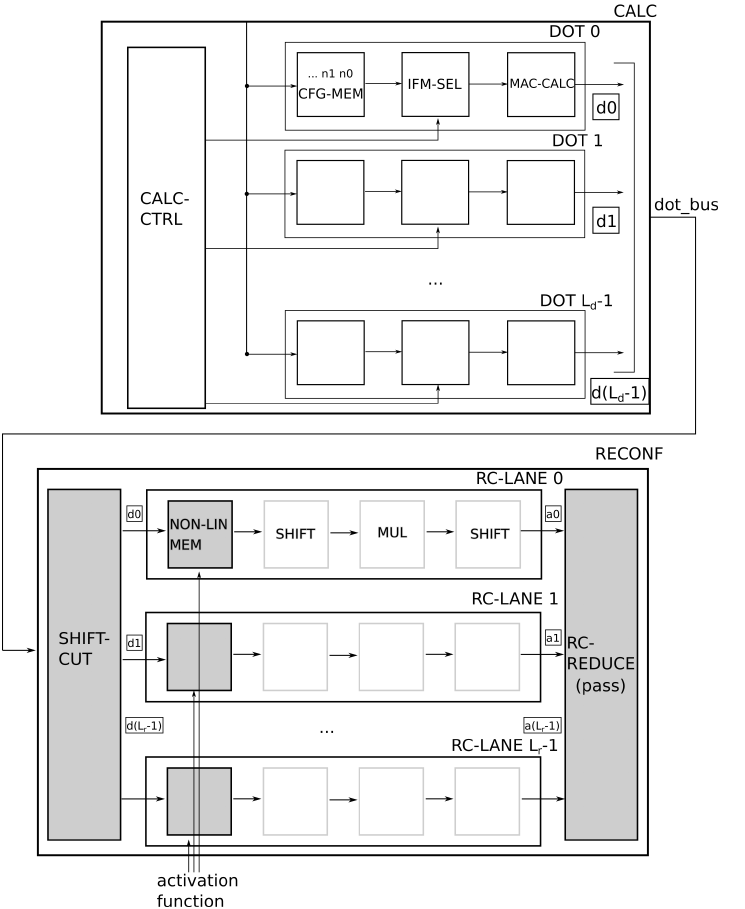
Figure 10. The RECONF architecture—MLP layer